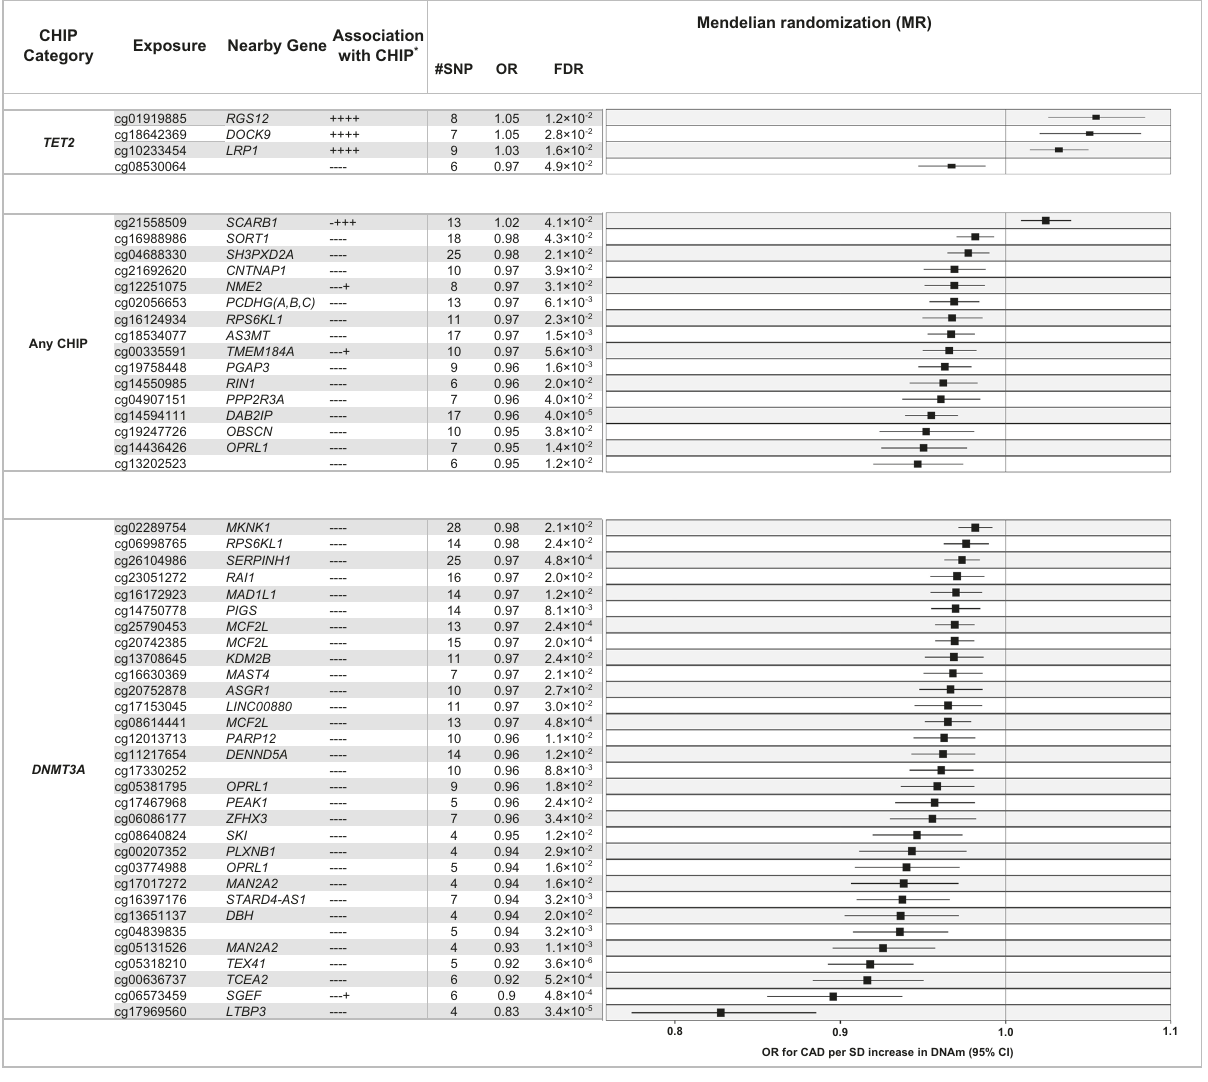
( N =547,261). Only exposure CpGs showing causal evidence in the MR analysis (FDR<0.05 based on P -values from two-sided χ 2 test) are presented here; full summarystatisticsareavailableinSupplementaryData7.* ” AssociationwithCHIP ” : “ + ” or “ - ” signs indicate effect directions for associations with CHIP, DNMT3A or TET2 in the meta-EWAS of CHS AA, CHS EA, ARIC AA, and ARIC EA EWAS. #SNP: number of SNPs included in the MR analysis for each